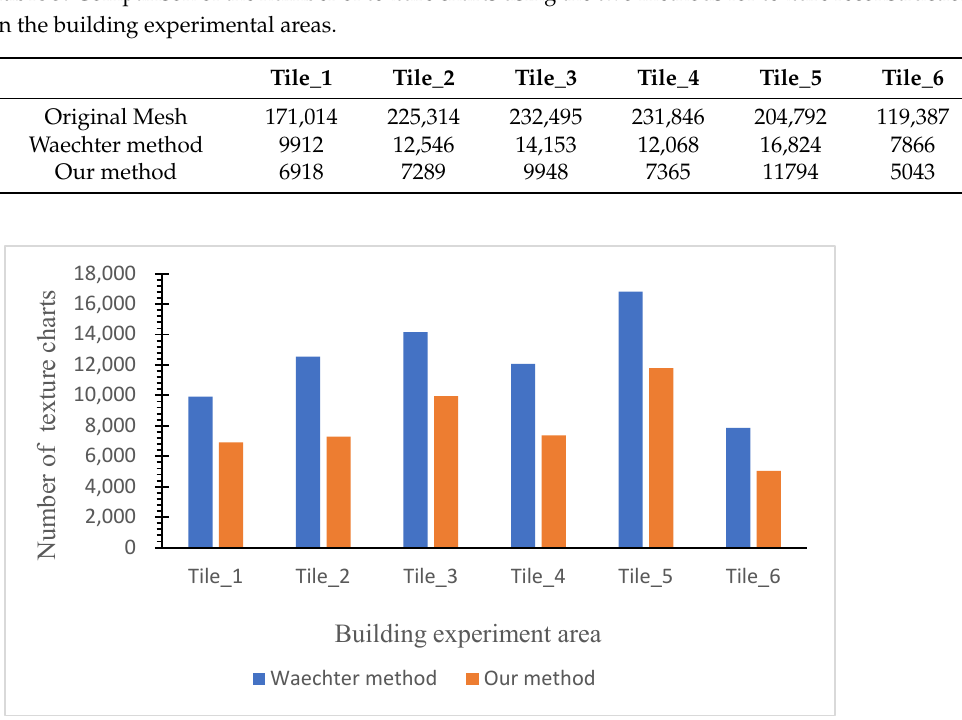
Figure 18. Bar graph for the number of texture charts in building experimental area comparison.